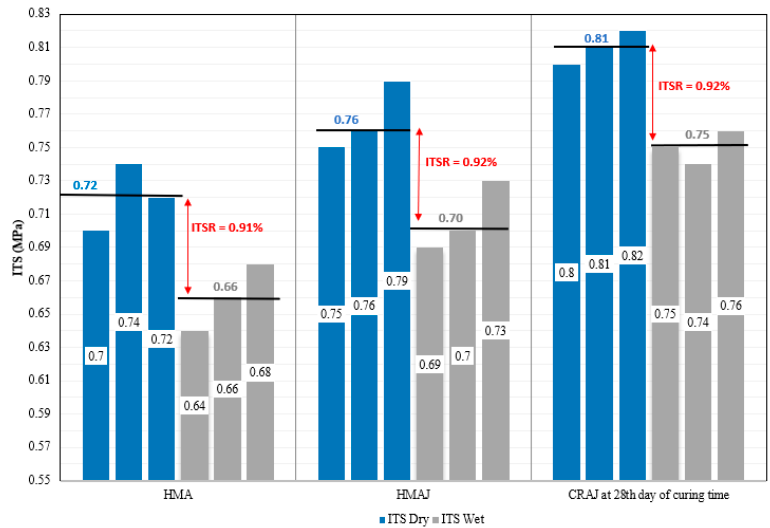
Figure 17. Dry vs. wet ITS.